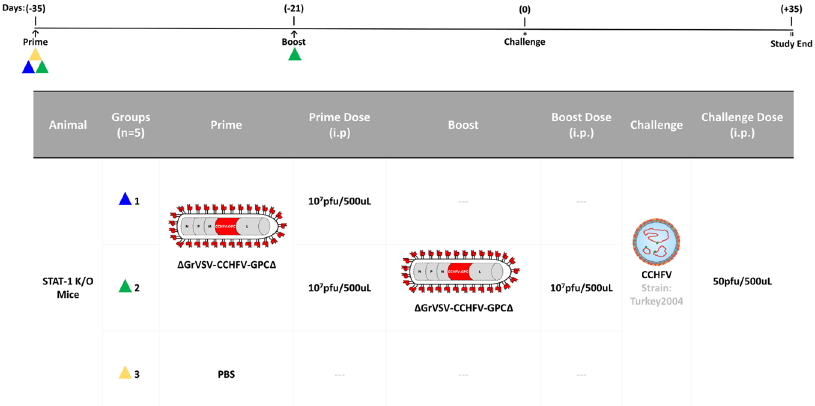
Figure 3. In vivo CCHFV vaccine study. Dosing schedule outlined above and experimental conditions including animal type, number, group, prime/boost/challenge conditions, routes, and dose amounts are outlined in the table. Flow chart showing vaccination (triangles), sampling days (arrows), and day of challenge ( * ).